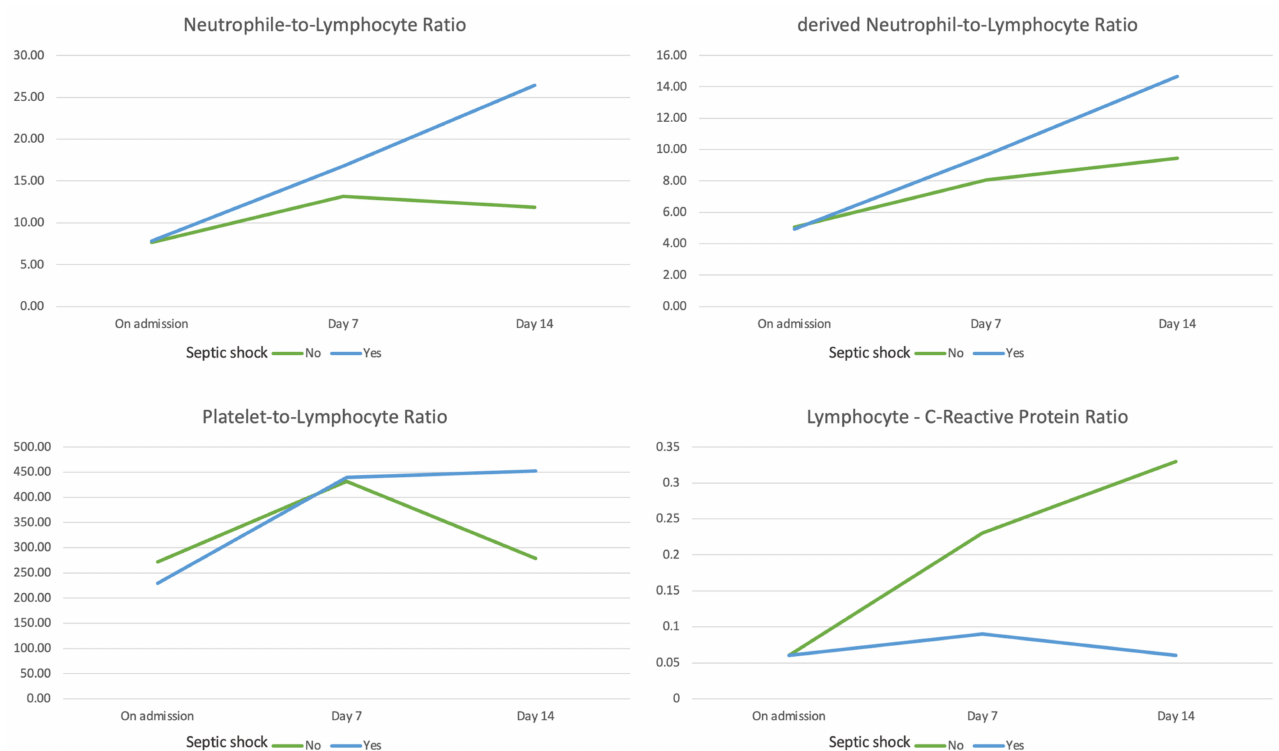
Figure 1. Time-dependent variation in the values of the hematological biomarkers on admission, at day 7, and at day 14.